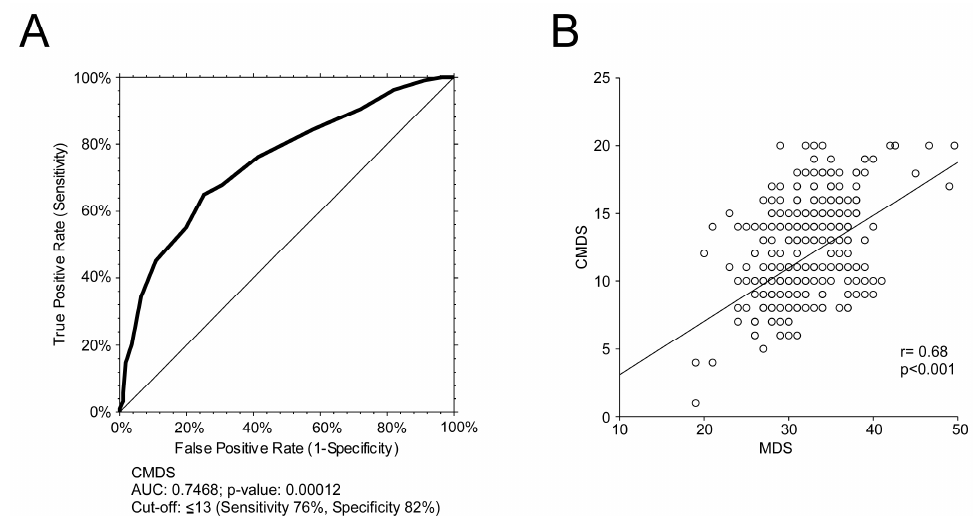
Figure 2. Discriminative power of the CMDS to identify adherence to the MedDiet using the MDS as reference score. The correlation analysis was estimated using Spearman Correlation Coefficient (r); ( p ) indicates statistical significance. Each dot represents a single subject. ( A ) ROC curve of CMDS and MDS to identify adherence to the MedDiet using MDS as reference. The cut-off point for the reference score was 30, in accordance with previous studies, which consider that the upper tertile represents greater adherence to the MedDiet; ( B ) Correlation analysis of CMDS and MDS overall score.